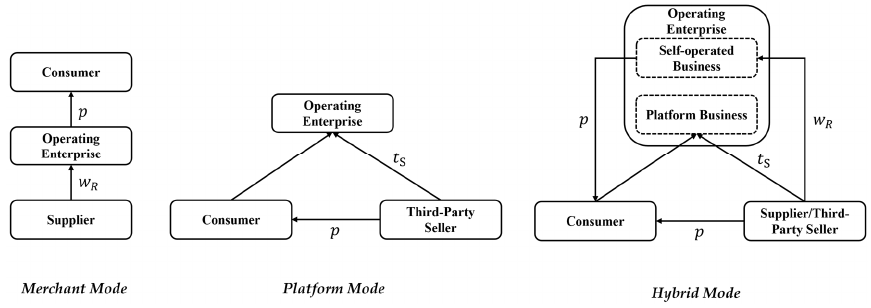
Figure 2. The capital flow of the merchant mode, platform mode, and hybrid mode.